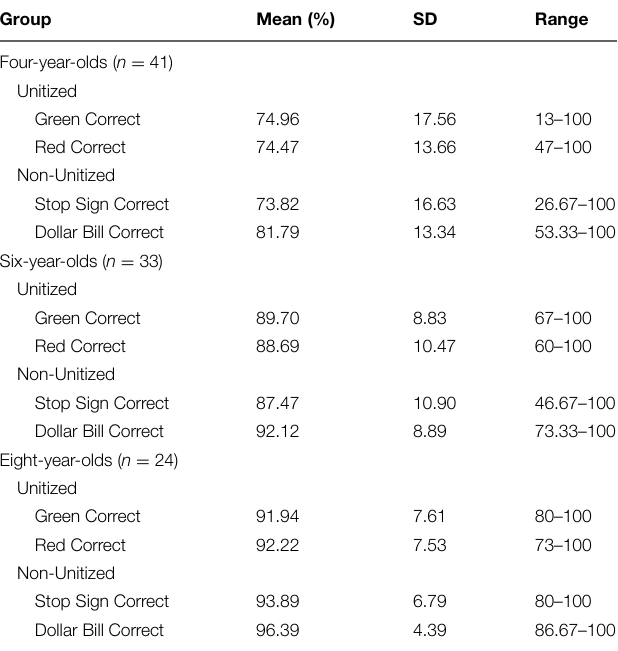
TABLE 1 | Descriptive statistics for memory performance (percent correct) by age and trial type.